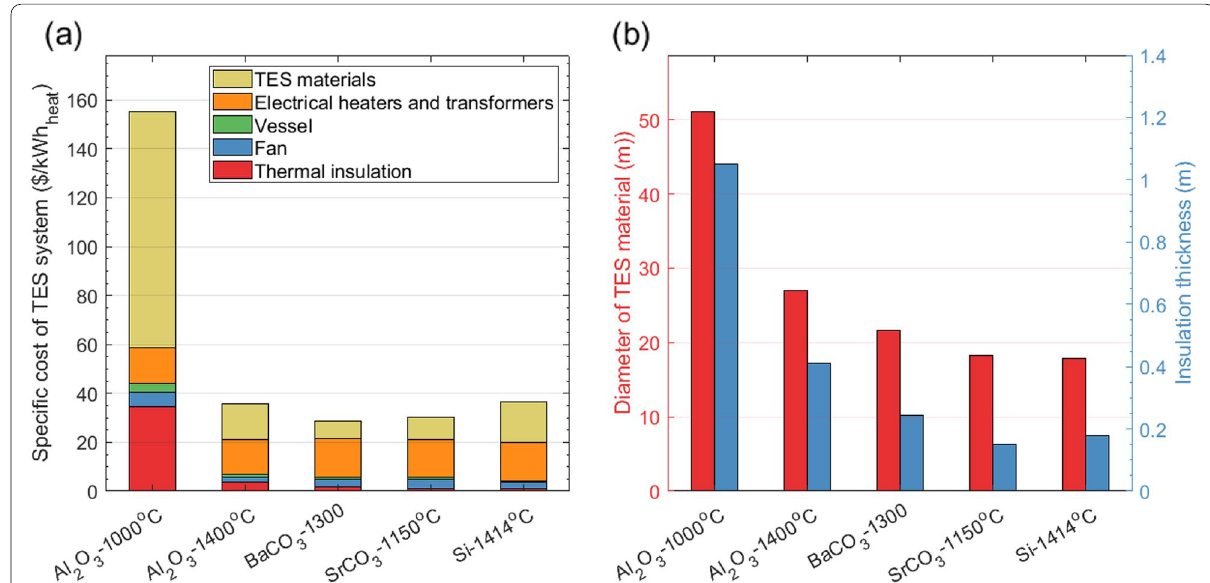
Fig. 7 a Cost of the components in the TES system and b the corresponding diameter of TES material and insulation thickness for different TES materials and temperature. The energy densities of BaCO 3 and SrCO 3 are specified as their upper bound values in Table